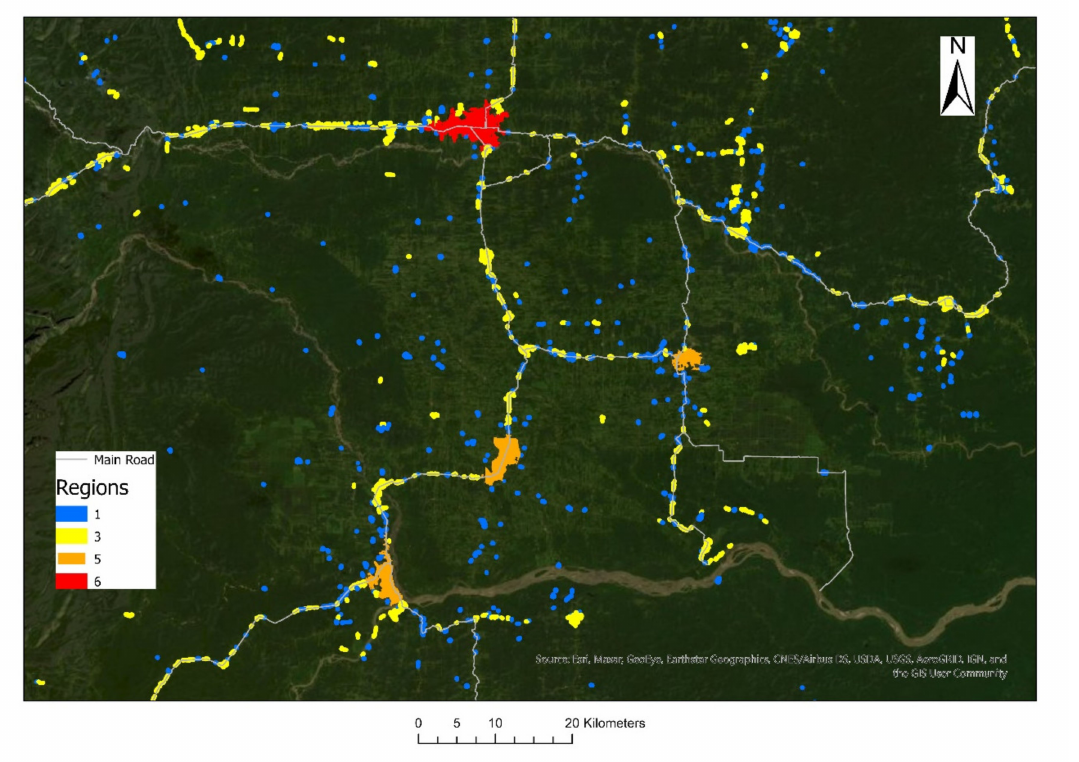
Figure 3. Urban regions 1, 3, 5, and 6: An Amazonian urban complex system. The outline widths of the urban zones are amplified to better visualize their